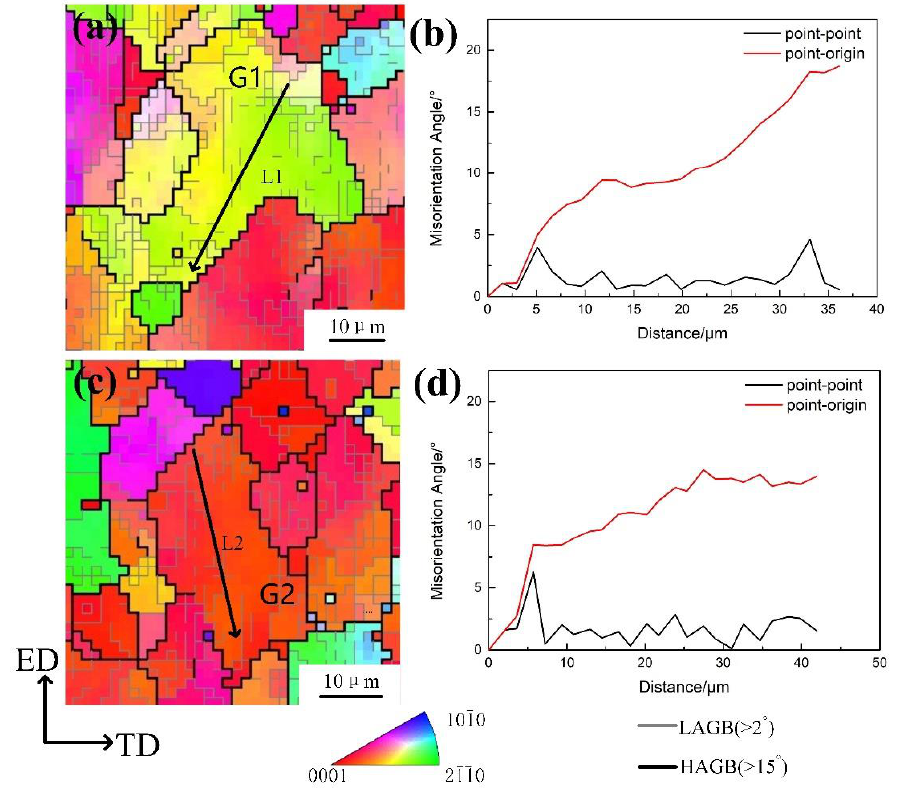
Figure 6. ( a , c ) the enlarged views of region A and region B in Figure 5b, ( b , d ) the misorientation distribution along L1 and L2,